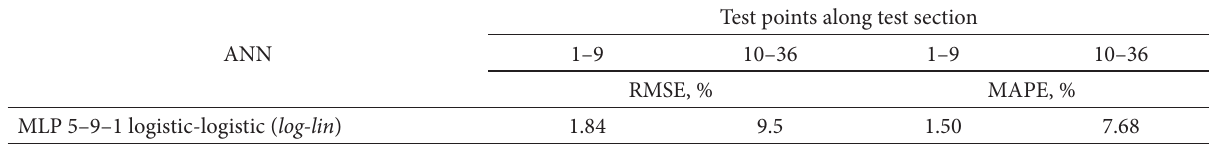
Fig. 7. FWD deflection basin parameters testing Table 5. Errors when evaluating by ANN the total bituminous layer thickness from testing section